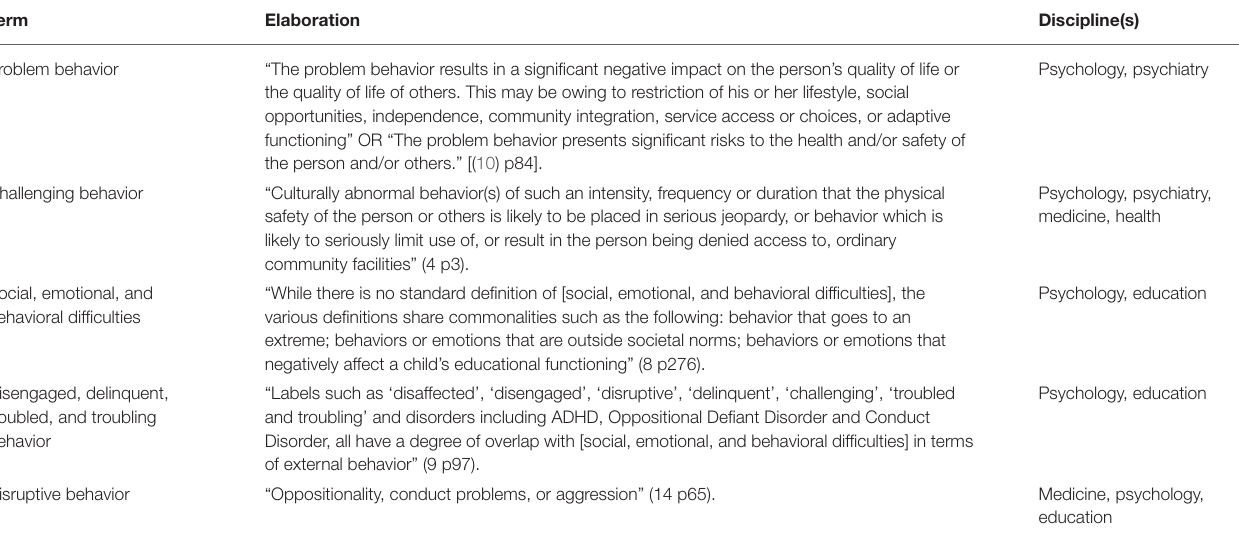
TABLE 1 | Terms for concerning